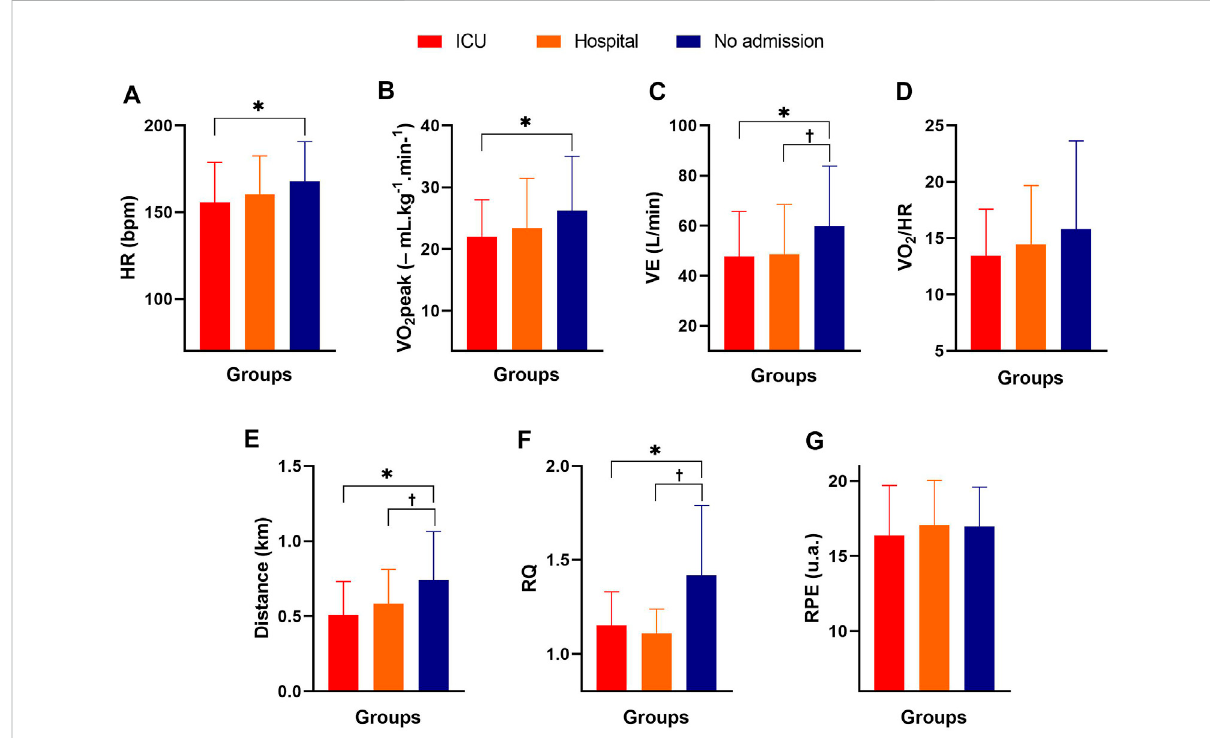
FIGURE 2 Cardiopulmonary parameters of male and female COVID-19 survivors in the ICU, hospitalized, and non-hospitalized groups. Note: data are expressed as the mean and standard deviation; Panel (A) = HR (heart rate); Panel (B) = VO 2 peak (peak oxygen consumption); Panel (C) = VE (ventilation); Panel (D) = VO 2 /HR (relationship between oxygen consumption and heart rate); Panel (E) = distance; Panel (F) = VCO 2 /VO 2 (ratio between respiratory exchanges); Panel (G) = RPE (rating of perceived exertion); * = signi fi cant difference between the non-hospitalized group andtheICUgroup; † =signi fi cantdifferencebetweenthenon-hospitalizedandhospitalizedgroups.One-wayANOVAwithBonferroniposthoctest. Level of signi fi cance established = p <